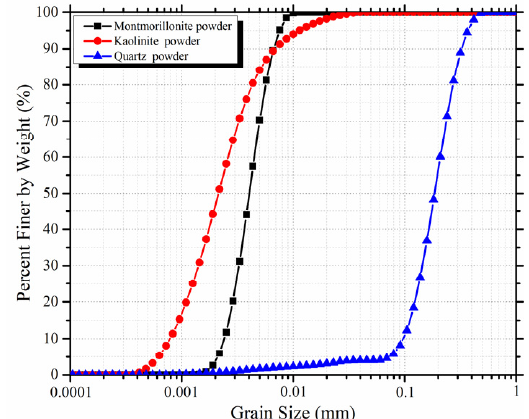
Figure 1. The grain size distributions of quartz, kaolinite, and montmorillonite. From left to right, the red curve, black curve, and blue curve indicate grain size distributions of kaolinite, montmorillonite, and curve, respectively. The particle size of quartz mineral powder is the largest among the three kinds of mineral powder. Table 1. Basic properties of quartz, kaolinite, and montmorillonite used in this study. Property.